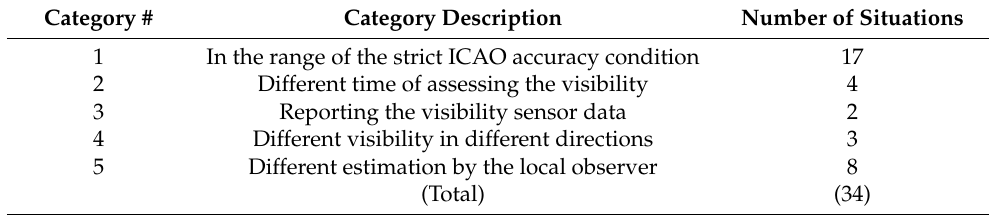
Table 10. Classification of the situations with the lowest visibility ranges (i.e., 600 m or lower) from the extended validation